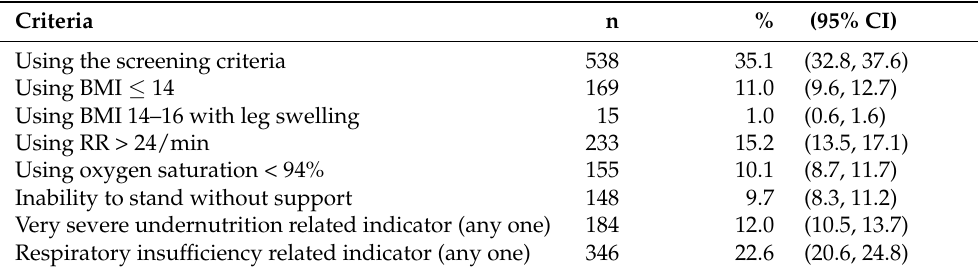
Table 5. Burden of ‘high risk of severe illness’ at notification using our screening among adults ( ≥ 15 years) with TB (without known drug-resistant disease at diagnosis) from public health facilities